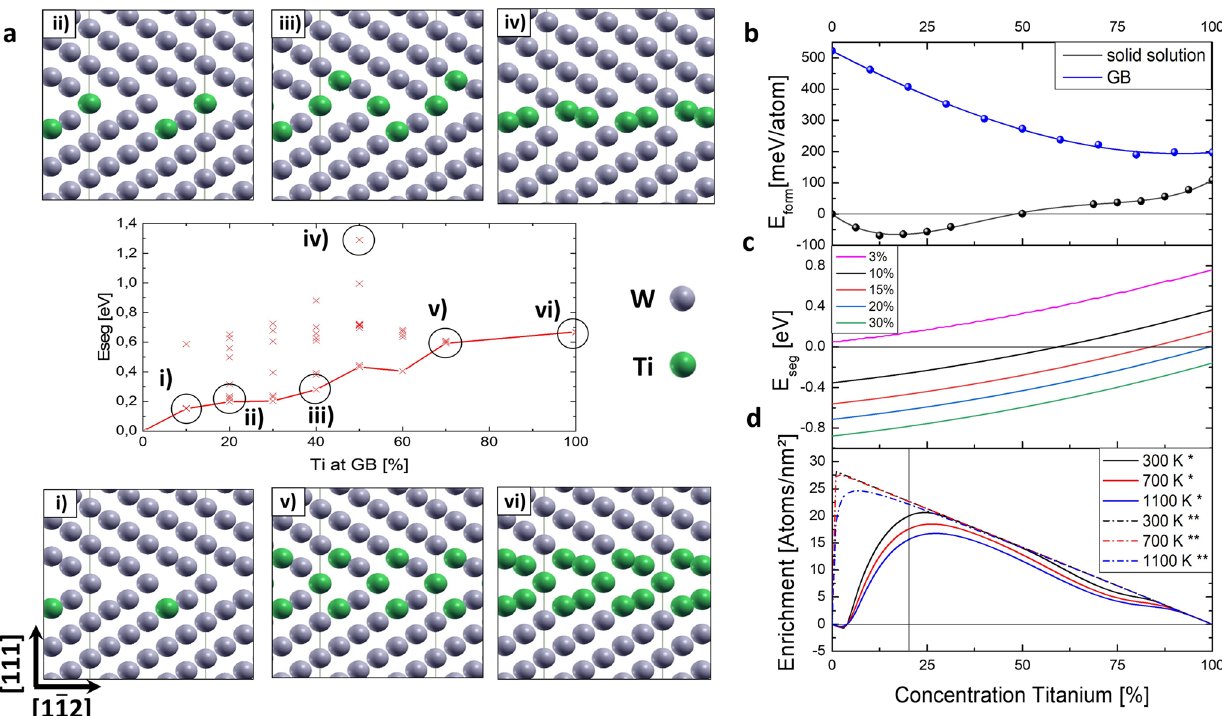
Fig. 5 Atomistic modelling of the Ti segregation and enrichment as well as the formation energy of W 1-x Ti x in bulk and at the grain boundary. a GB segregation at the dilute limit with different Ti concentrations from (i) to (iv), as well as the corresponding illustrated Ti-atoms distribution (green) at the GB. b Formation energy of the GB- and Bulk-WTi. The Titanium concentration on the x-axis refers to GB and bulk Titanium concentration. c Segregation at fi xed bulk Ti concentration. The Titanium concentration on the x-axis refers to GB Titanium concentration. d Ti enrichment of the GB. The * and ** in the legend represent averaged E seg and E seg = − 0.5 eV, respectively. The Titanium concentration on the x-axis refers to the bulk Titanium